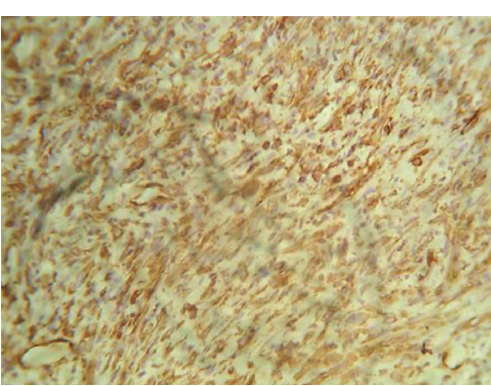
Figure 5: Spindle shaped cell showing nuclear pleomorphism (40x).